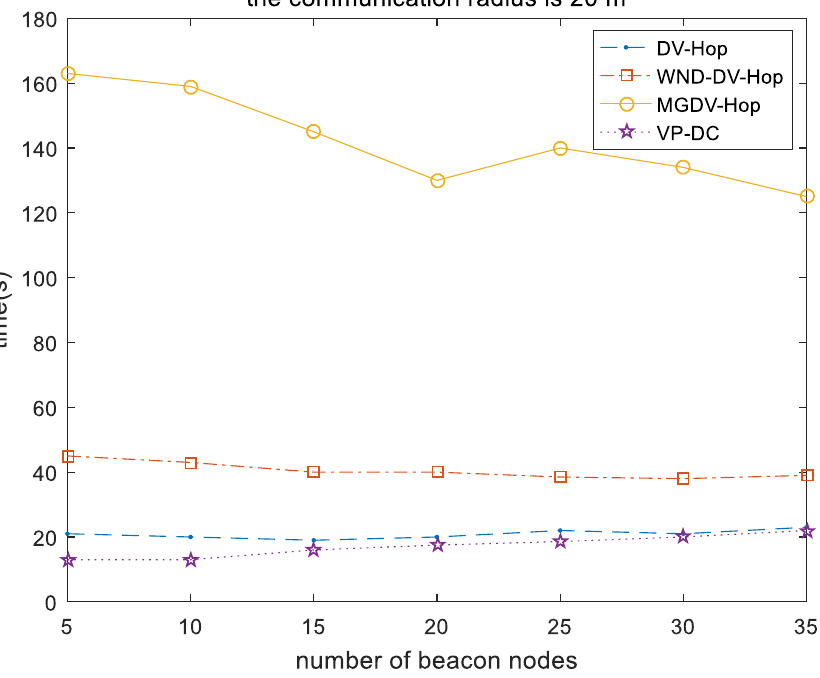
Figure 8. Relationship between the number of beacon nodes and the operation time of the algorithm.